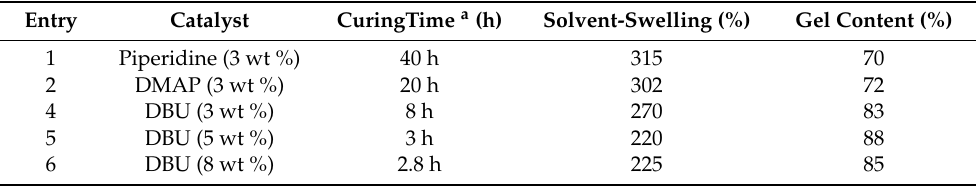
Table 2. Optimization of the preparation reaction conditions.